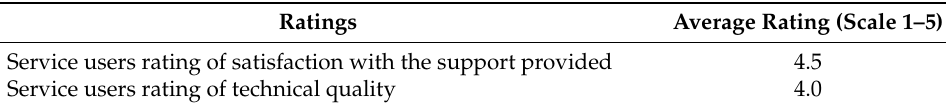
Table 2. Service user ratings following teletherapy